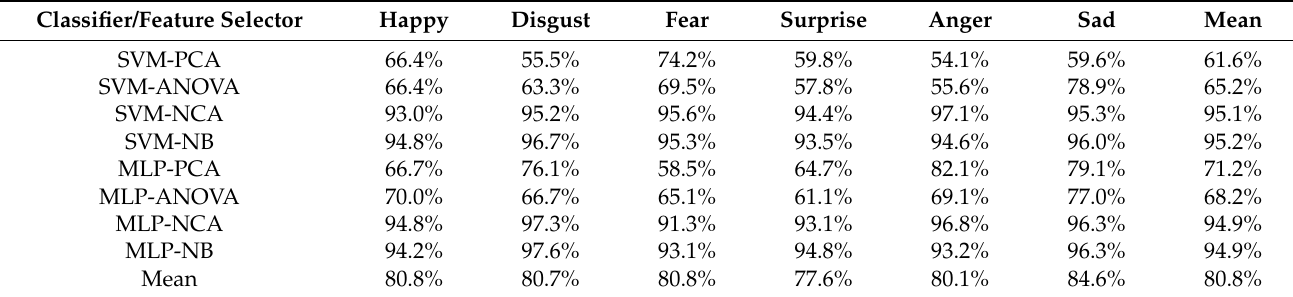
Table 3. Mean accuracy results for affective state recognition based on 27 sub-ROIs reported from implementation of SVM and MLP classifiers with PCA, ANOVA, NCA, and NB feature selection